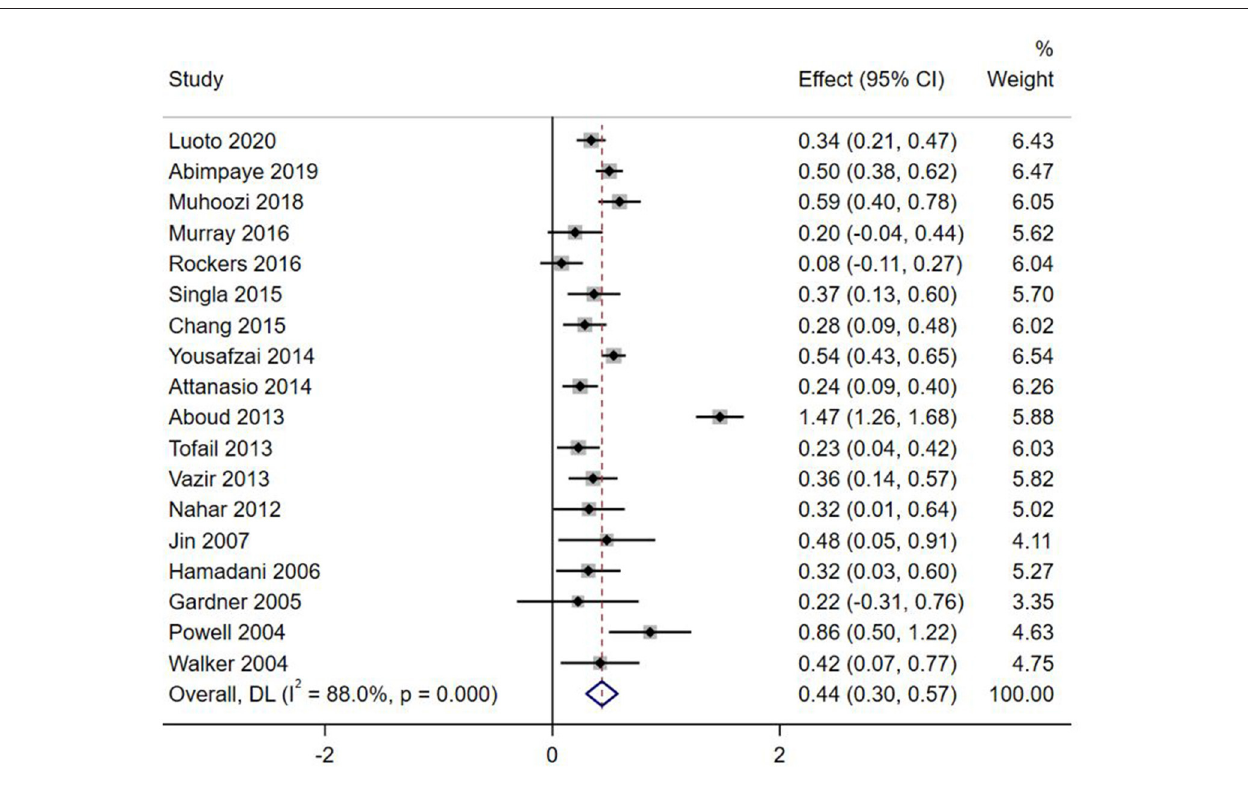
FIGURE 2 | Effect sizes on Cognitive